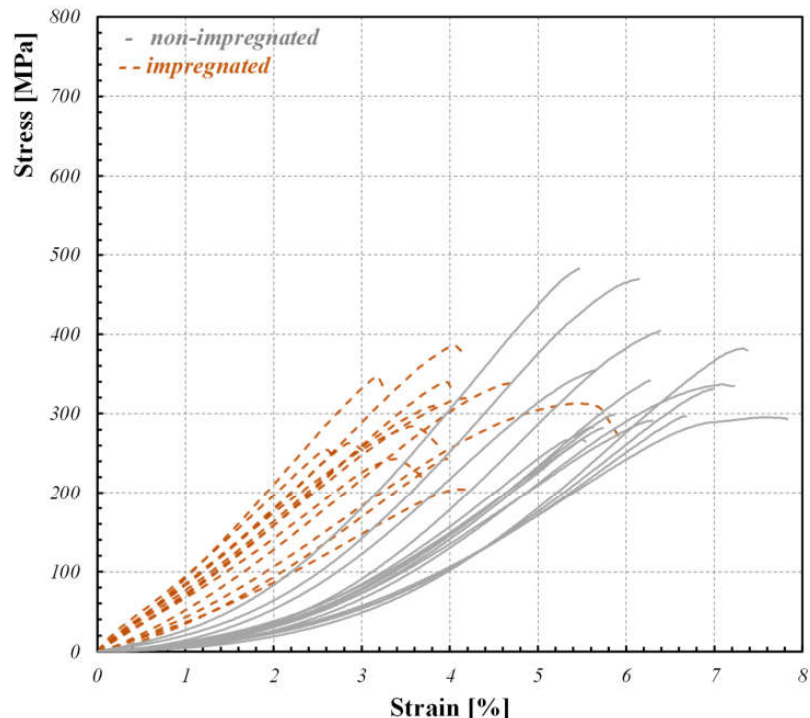
Figure 10. Tensile test results of non-impregnated_Y_tensile and impregnated_Y_tensile series of specimens.